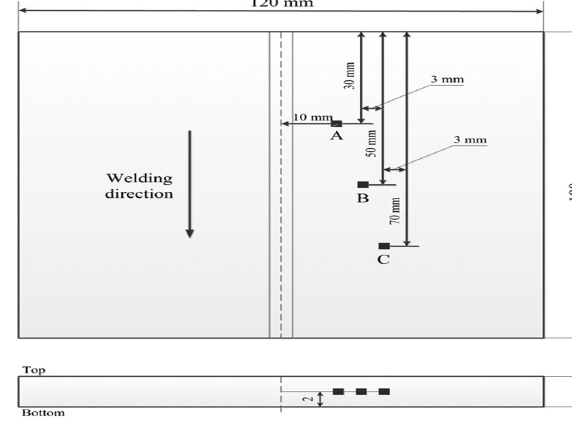
Figure 4: Constraints of mechanical model in simulation of welding transient stress.